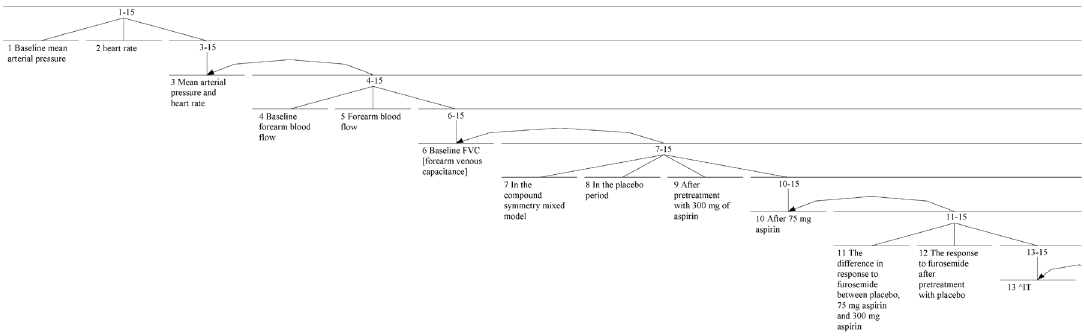
Figure 7. Theme pattern in the English